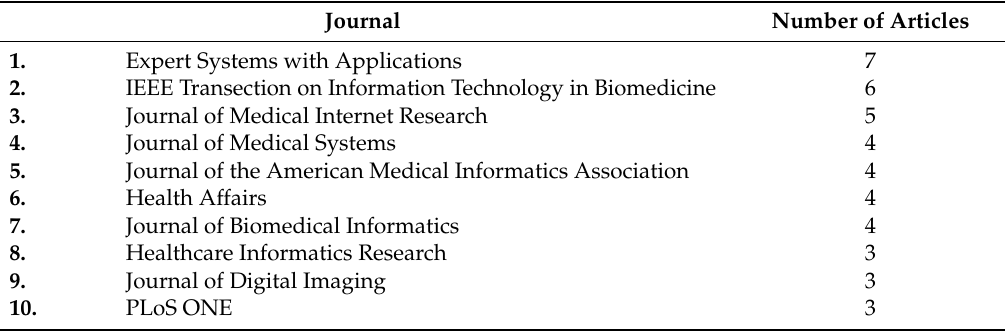
Table 4. Top 10 journals on application of data mining in healthcare.